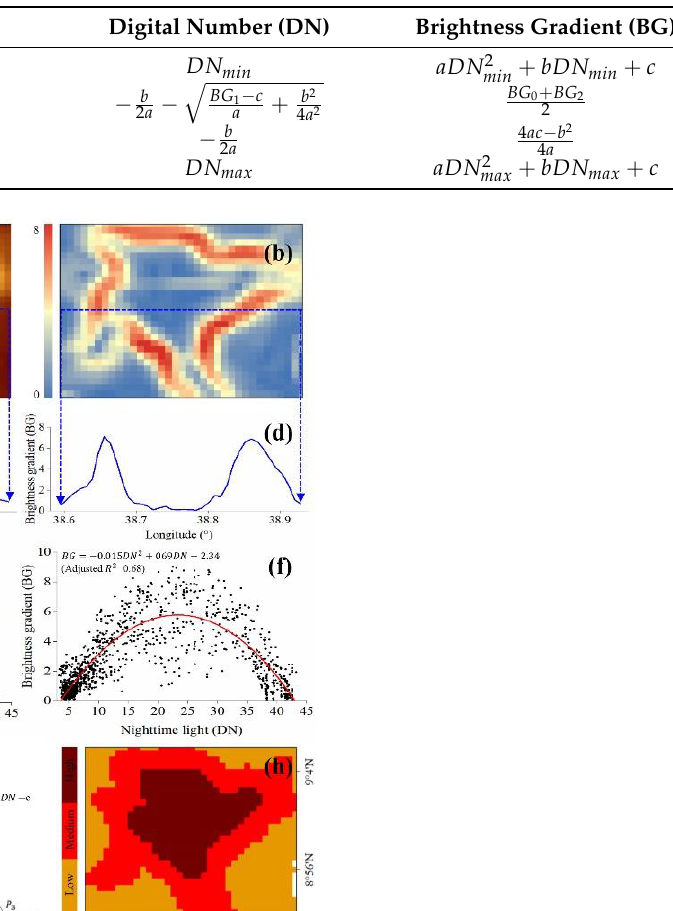
Table 1. Calculations for the split points in Figure 3.